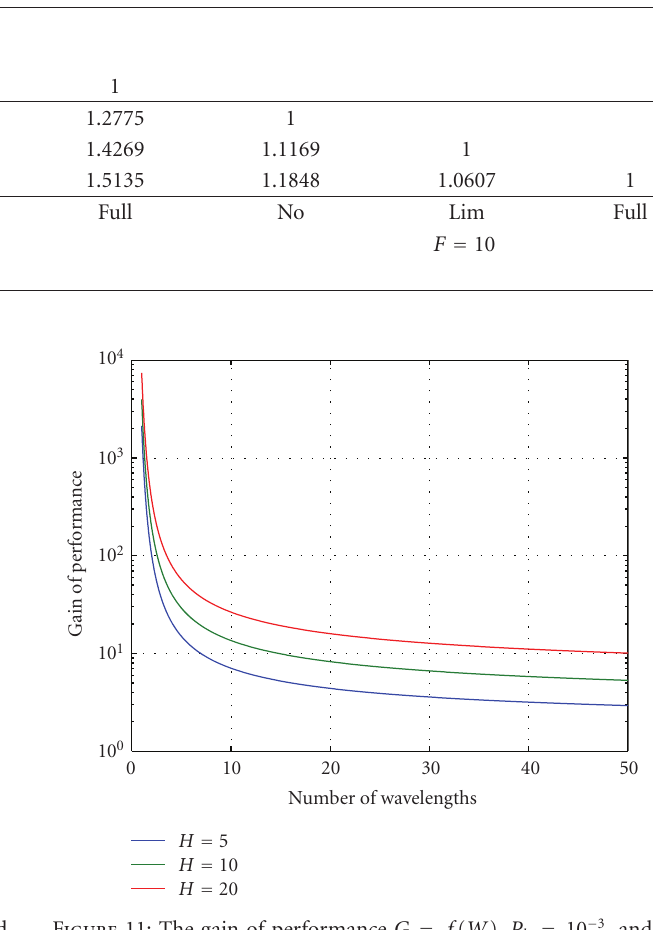
Figure 10: The gain of performance G W = f ( W ), P b = 10 − 3 , and F = 10 No/ F = 1 no.